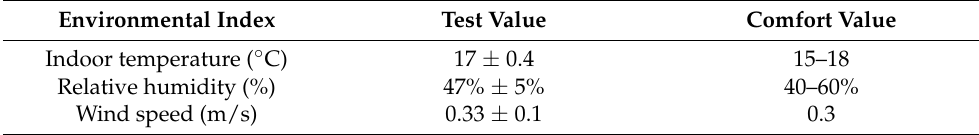
Table 2. Environment of the experimental